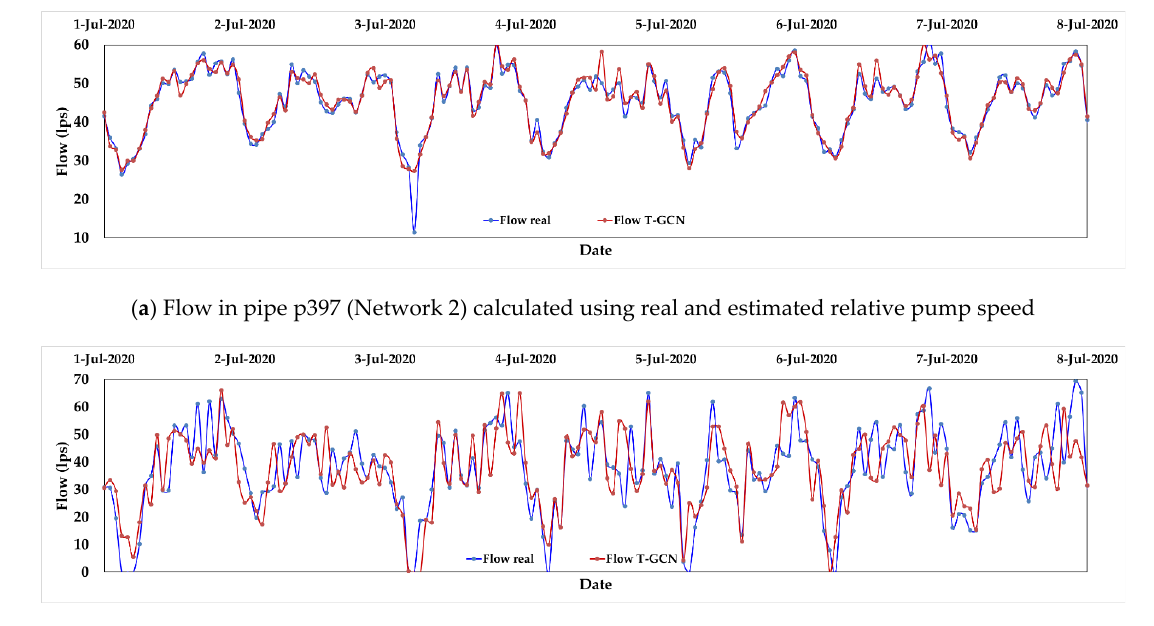
Figure 9. Comparison between estimated flow based on real and estimated relative pump